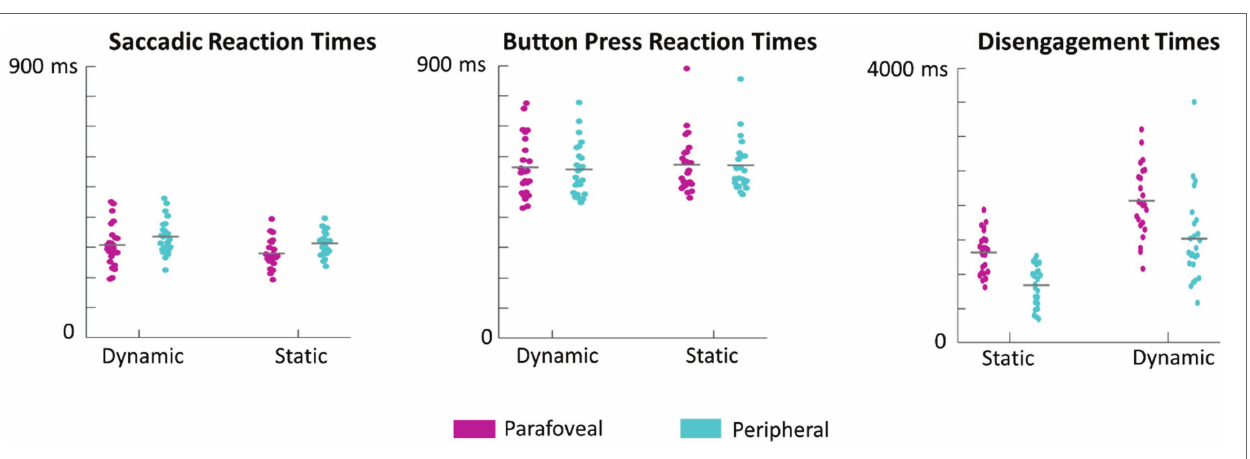
FIGURE 8 | Swarm plots of subject averages in saccadic reaction times, button press reaction times, and disengagement times. It is important to note that saccadic reaction times are calculated as the difference between the time of saccade onset and the time of the cue onset. Button press reaction times are calculated as the difference between when the button was pressed and the time of target onset. Disengagement time is the difference between the time the eyes first left the target and the time of target